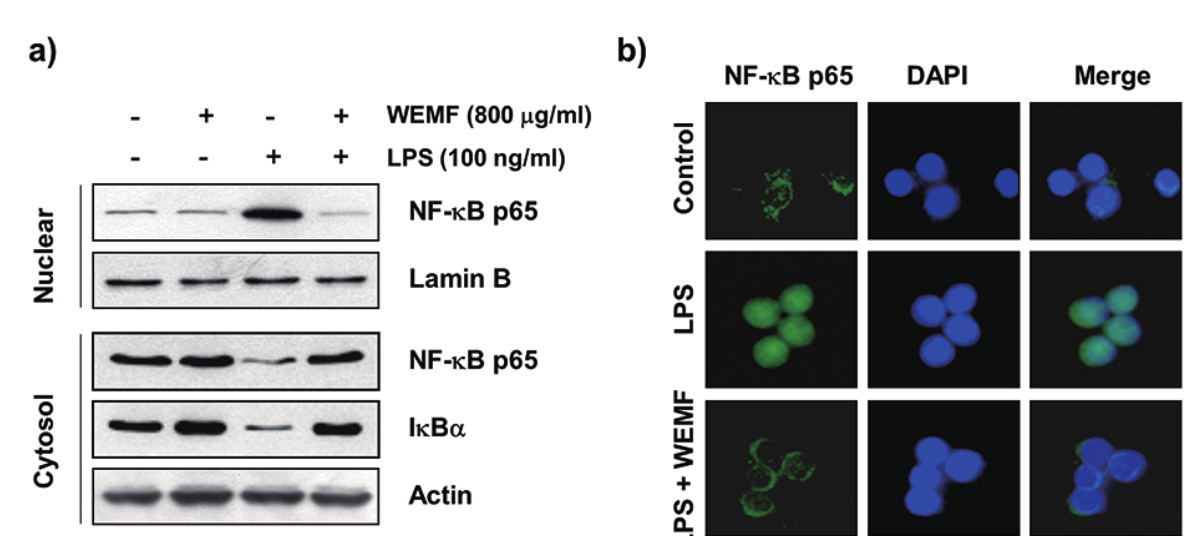
Figure 4 - Inhibition of NF-κB nuclear translocation by WEMF in LPS-stimulated RAW 264.7 macrophages. (a) The cells were pretreated with 800 μg/ml WEMF for 1 h before 100 ng/ml LPS treatment for 1 h. The nuclear and cytosolic proteins were prepared for Western blot analysis using anti-NF-κB p65 and anti-IκB-α antibodies and an ECL detection system. Lamin B and actin were used as internal controls for the nuclear and cytosolic fractions, respectively. (b) The cells were pretreated with 800 μg/ml WEMF for 1 h before 100 ng/ml LPS treatment. After 1 h of incubation, the localization of NF-κB p65 was visualized with fl uorescence microscopy after immunofl uorescence staining with anti-NF-κB p65 antibody (green). The cells were also stained with DAPI to visualize the nuclei (blue). The results are representative of those obtained from three independent